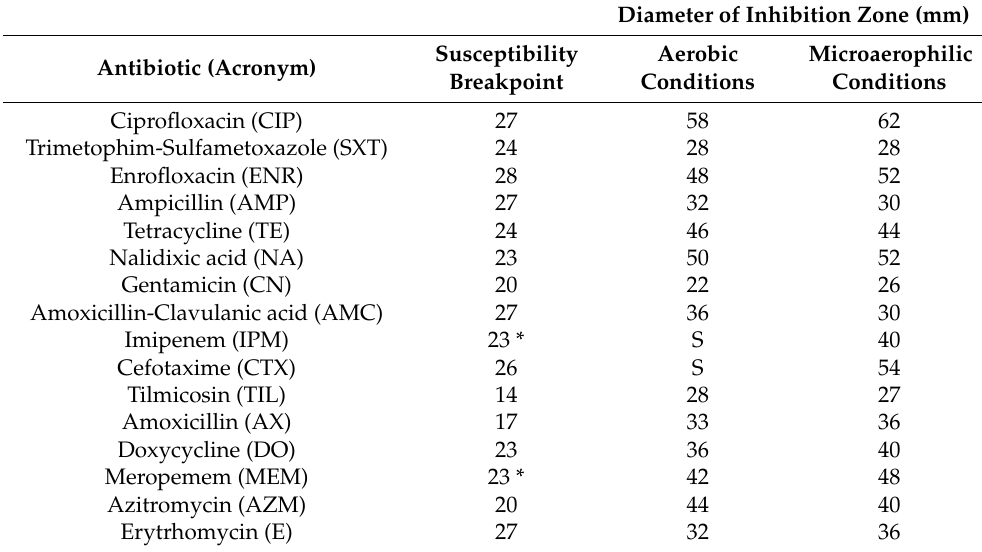
Table 3. Antibiotic susceptibility test performed on P. multocida detected in pet rabbit